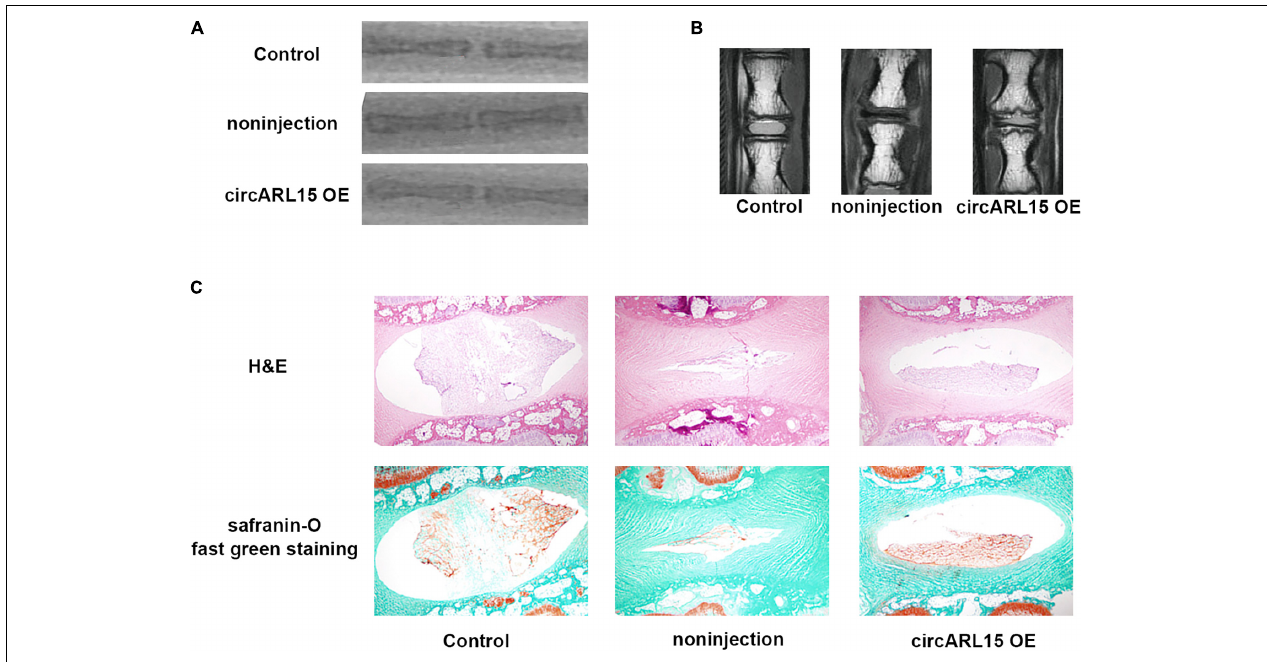
FIGURE 7 | Intradiscal injection of the circARL15 alleviates IDD in vivo . (A) Radiographs of the indicated groups were obtained 9 weeks after needle puncture. (B) MRIs of the indicated groups were obtained 9 weeks after needle puncture. (C) H&E and safranin-O/fast green staining of the IVDs in the indicated